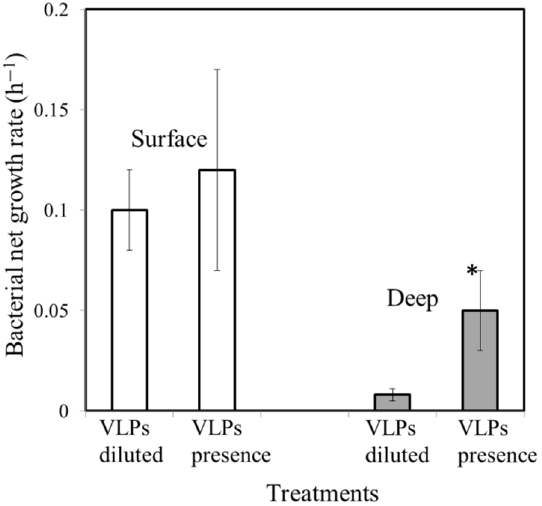
Figure 3. Bacterial net growth rates in 20% diluted (VLPs diluted) and grazing-free (<2 μm filtered waters; VLPs present) treatments in the sunlit surface (□) and dark, deep waters ( ■ ), respectively. *: difference is significant at the 0.05 level.